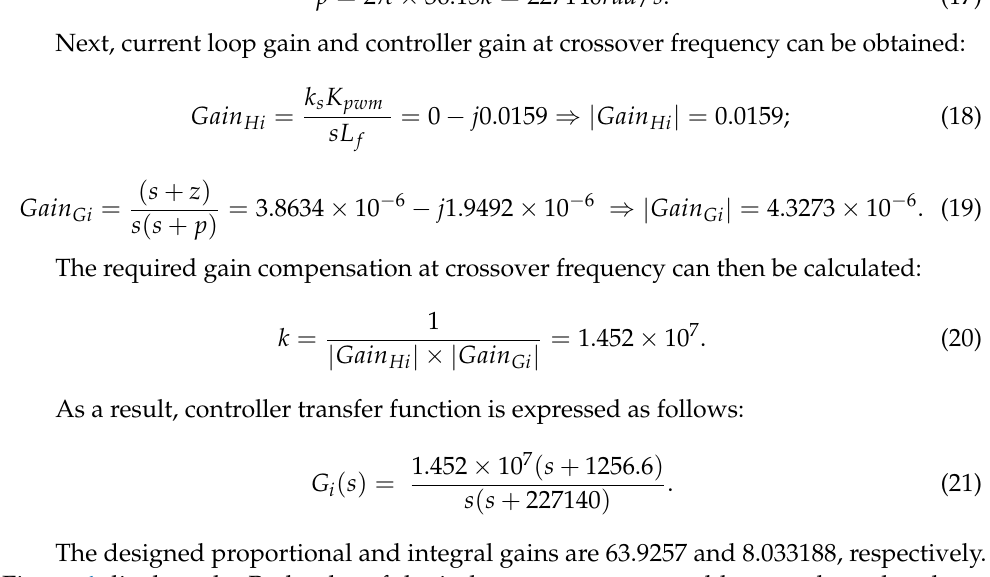
dc dc I Figure 7. Equivalent circuit of VSI voltage loop. According to Figure 7, the instantaneous AC power at AC side in SRF can be defined as follows: